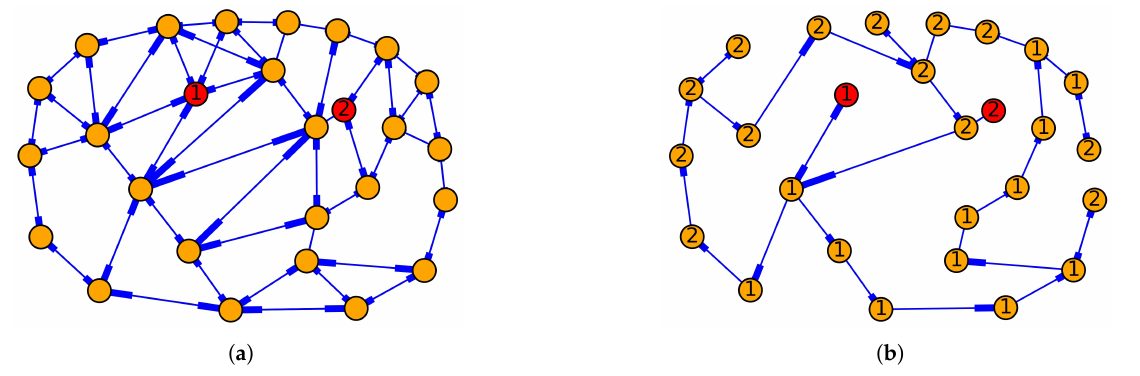
Figure 3. ( a ) Original Norway graph. ( b ) Resulting Norway graph after applying